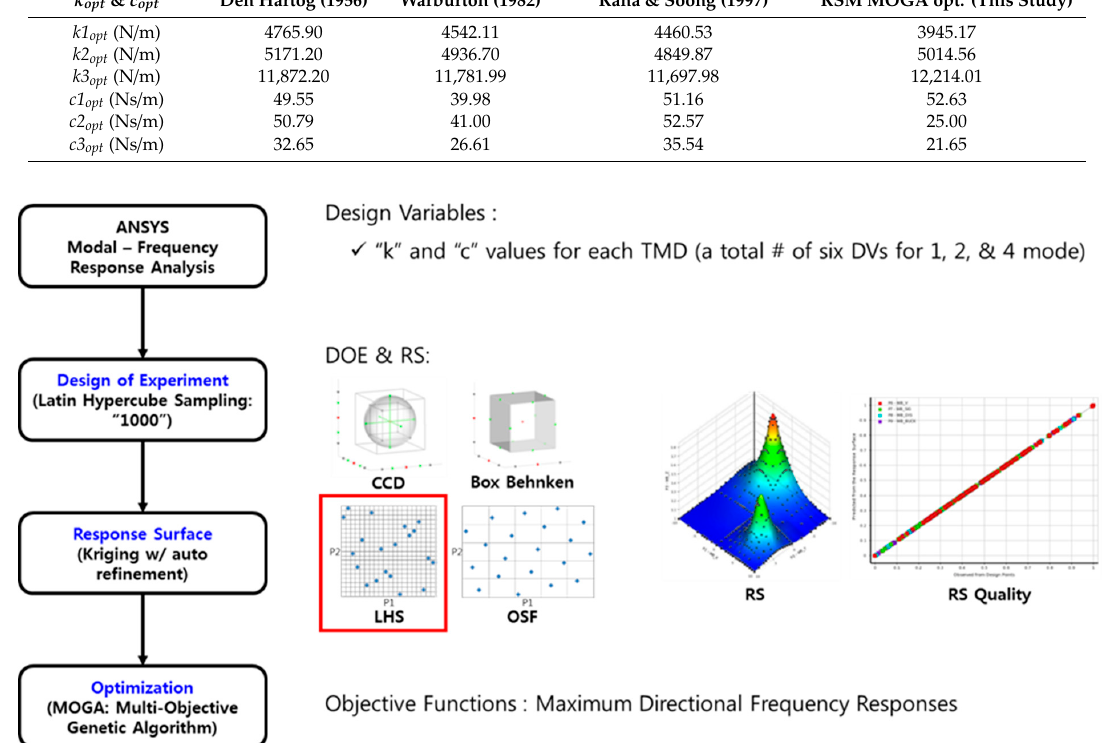
Figure 6. Conceptual diagram of the FRA-based TMD optimal design method using RSM and MOGA.